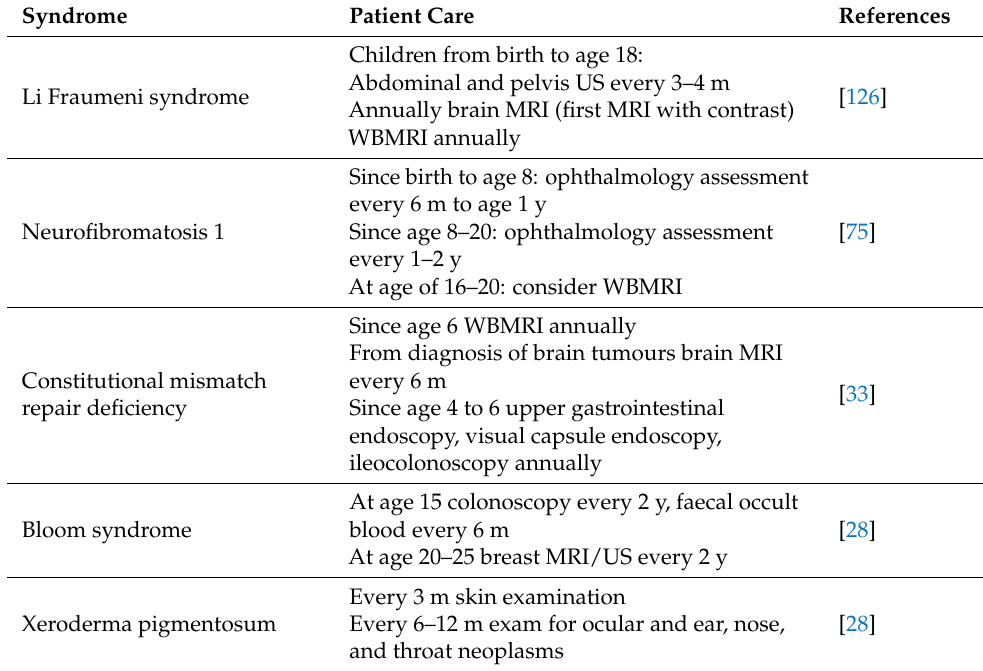
Table 1. Cancer predisposition syndromes with the need of more than haematological